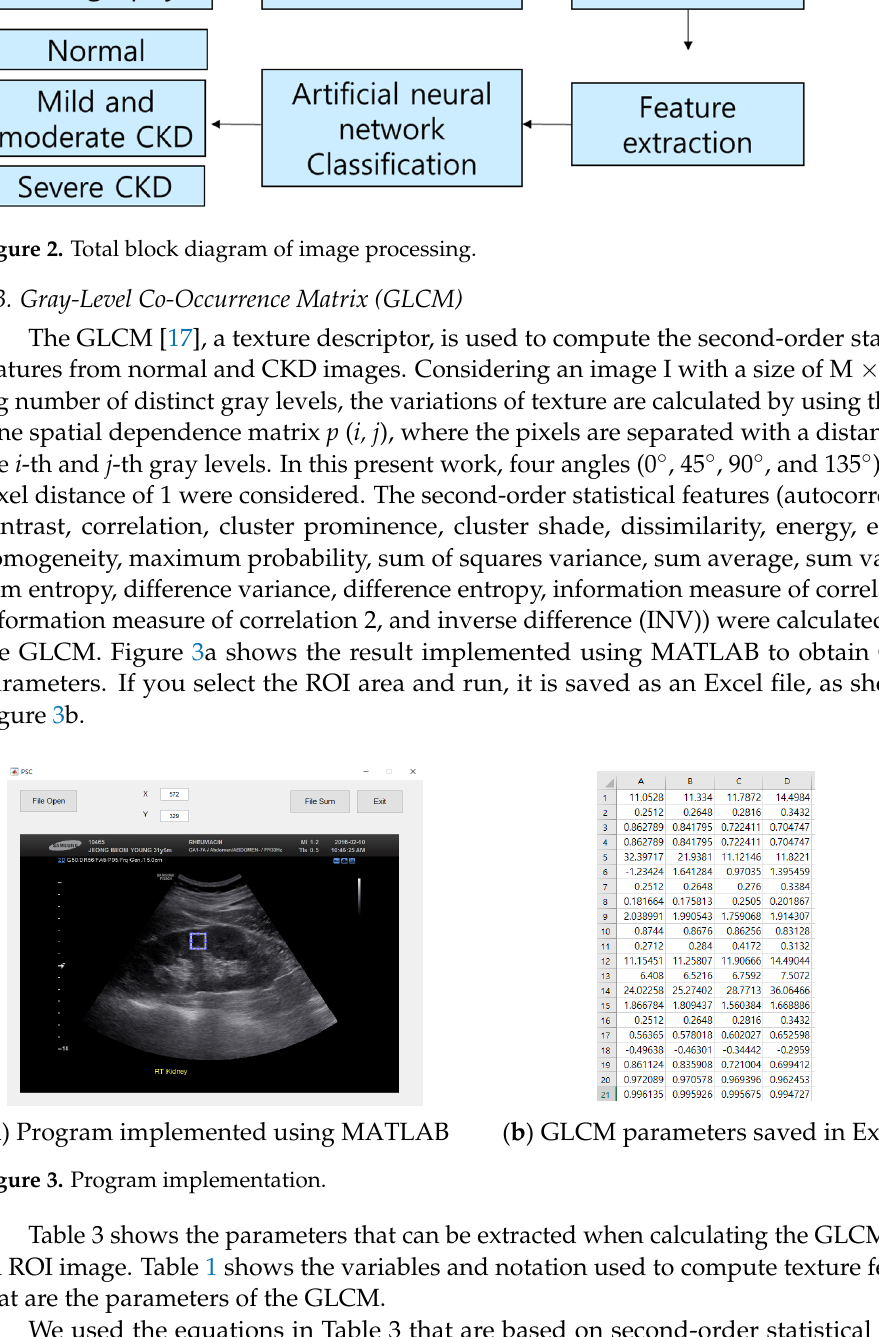
Figure 2. Total block diagram of image processing.